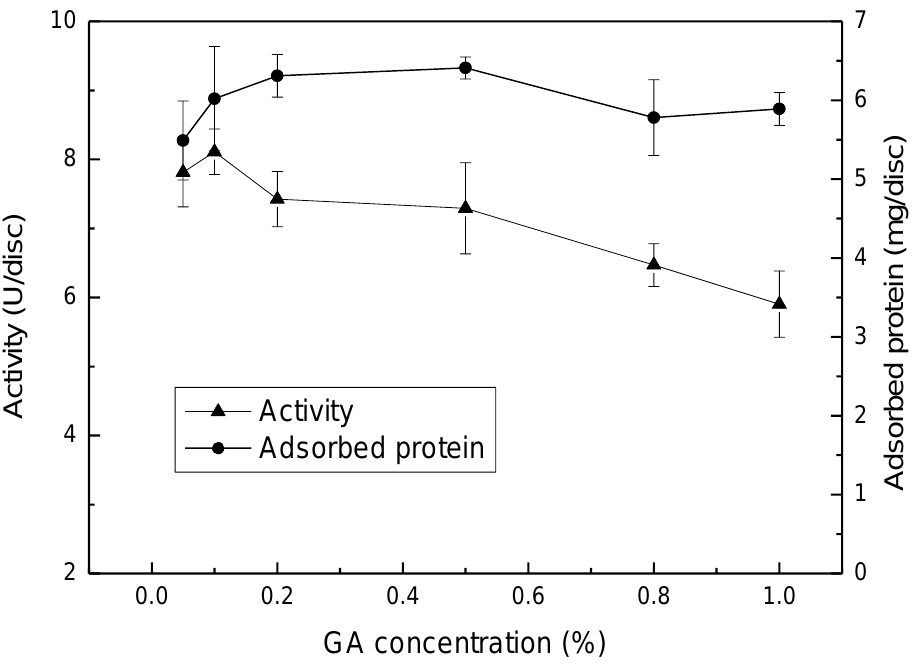
Figure 6. Effect of different concentrations of GA on CelA endoglucanase activity, and protein ad- sorption.